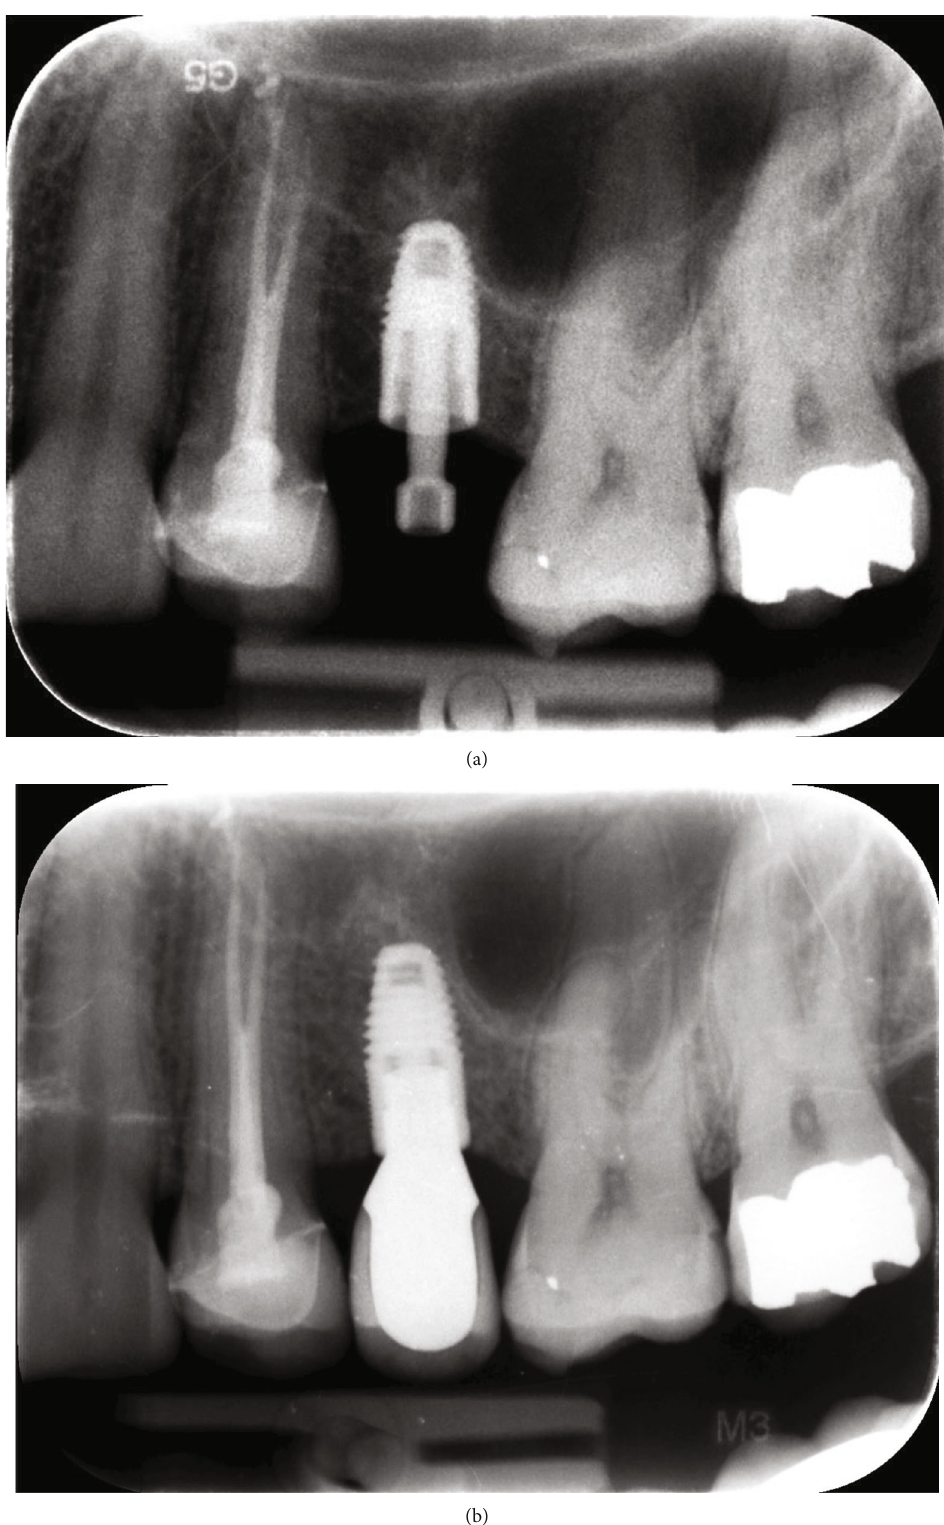
Figure 6: (a) Postoperatory endoral radiography. (b) Endoral radiography taken after 9 months from the